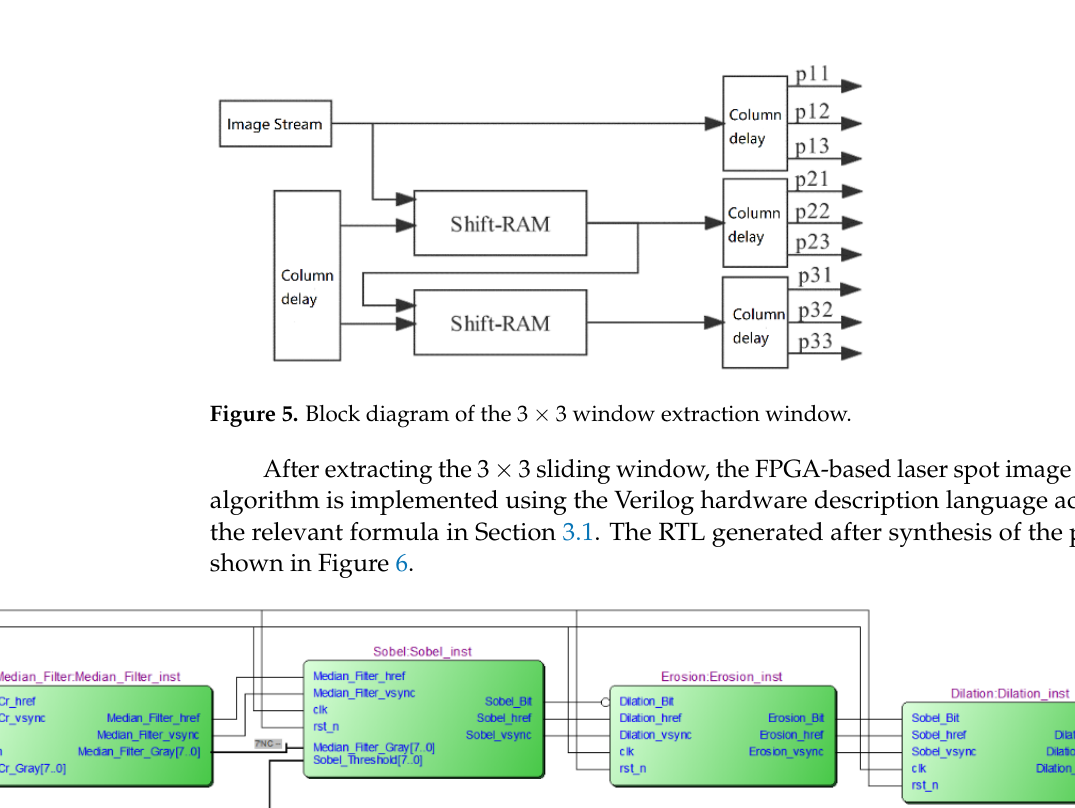
Figure 4. Shift register operation principle. The window extraction hardware block diagram is shown in Figure 5.